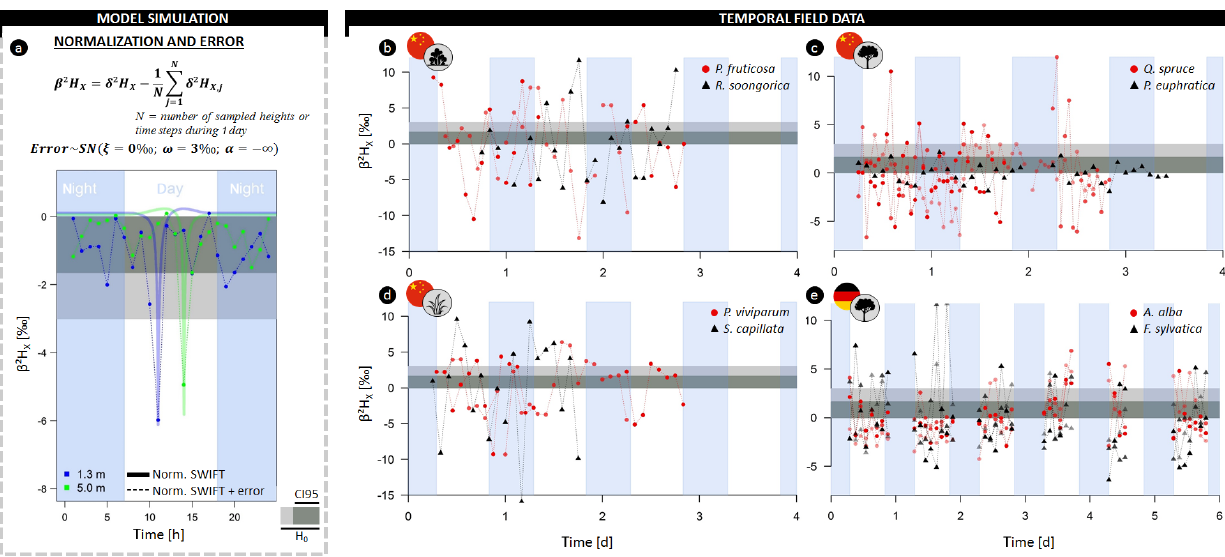
Figure 4. (a) Illustrative example of model simulations transformed in the normalized δ 2 H composition of xylem water ( β 2 H X ) at 1.3 (blue) and 5m (green) sampling heights with the formula provided. Thicker lines indicate model simulations without error, and lines connected by dots indicate a scenario of hourly sampling with consideration of the extraction error (i.e., a negative skew normal distribution; ξ = 0‰, the scale ω = 3‰, and shape α = −∞ ). (b–e) High temporal field measurements of β 2 H X of (b) two shrubs, (c) two trees, and (d) two herb species sampled in the Heihe River Basin (northwestern China) and (e) two tree species sampled in the Freiamt field site in southwest Germany. The horizontal gray-colored envelope in all panels delineates the acceptable variance from the stem mean according to the null model (H 0 ), i.e., assuming no variance along the length of a lignified plant aside from the potential extraction error (i.e., 3‰). Herein, the dark gray envelope indicates the confidence interval comprising 95% of potential extraction error (CI95). A breakdown of the field data on species and individual level is provided in the Supplement figures (Figs.